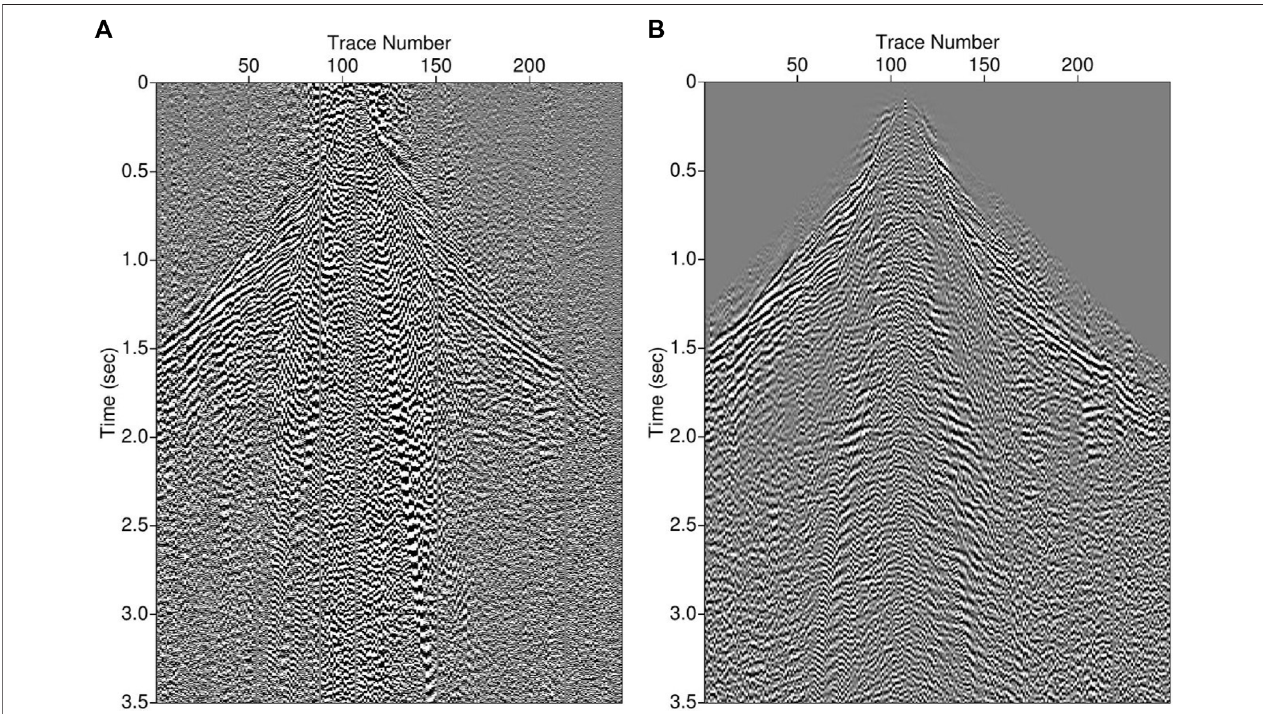
FIGURE 7 | Another example of a common-shot gather from Pirouette Mountain and Eleven-Mile Canyon before (A) and after (B) wavenumber-adaptive bandpass fi ltering. Waveforms before fi rst arrivals in the right panel are muted with a cosine taper near the fi rst arrivals. Coherent subsurface re fl ections become visible after fi ltering.